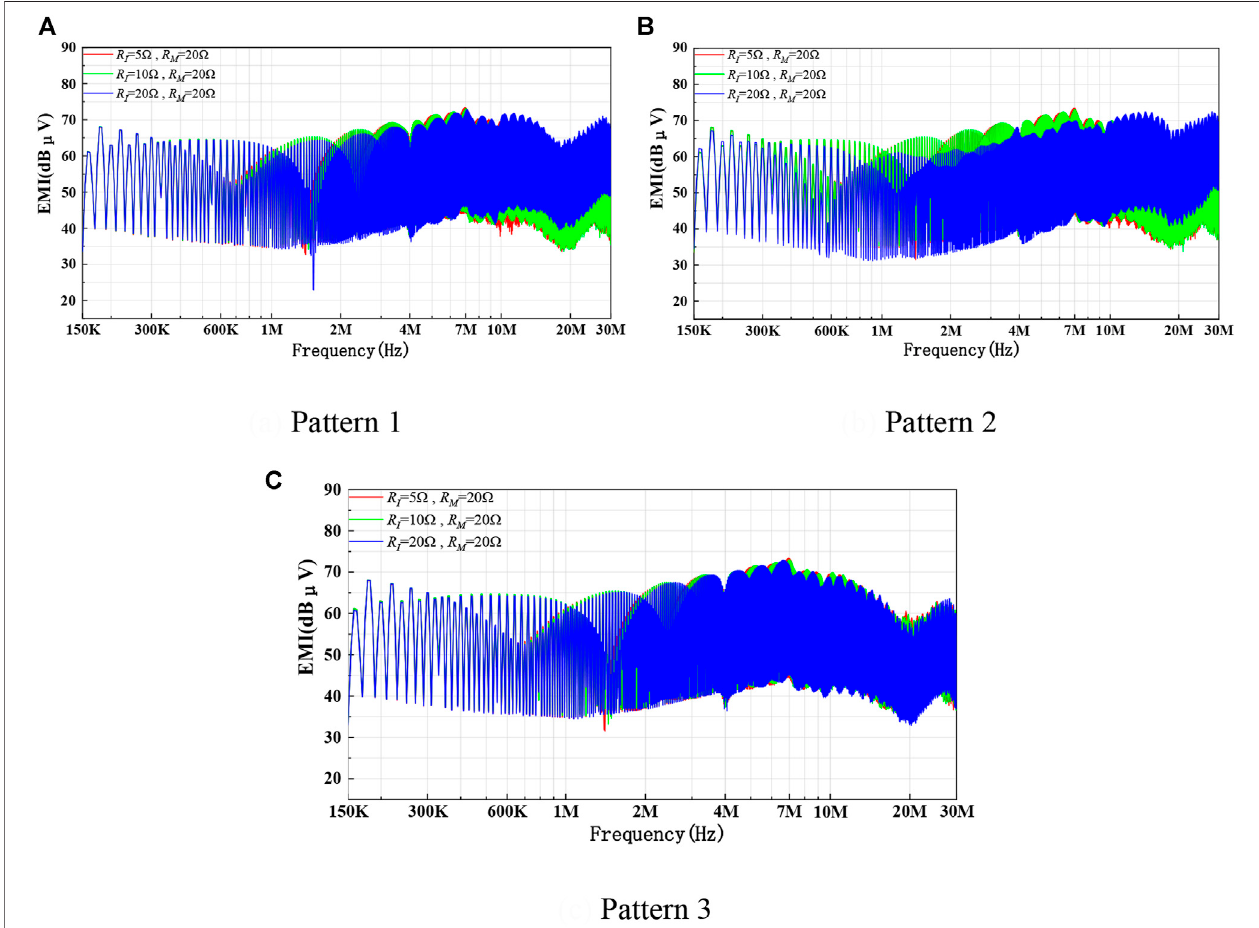
FIGURE 15 | Relationship between the gate resistor and CM EMI noise (changing gate resistor of Si IGBT). (A) Pattern 1, (B) pattern 2, and (C) pattern 3.